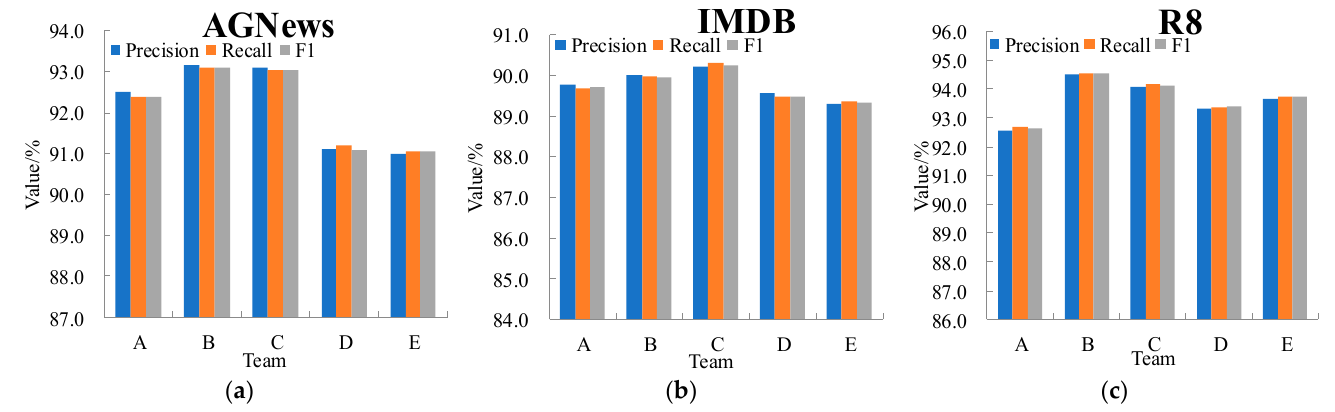
Figure 7. Experimental results for different size groups of convolution kernels. ( a ) represents the influence of different convolution kernel sizes on the classification effect of AGNews dataset; ( b ) represents the influence of different convolution kernel sizes on the classification effect of IMDB data sets; ( c ) represents the influence of different convolution kernel sizes on the classification effect of R8 dataset. Table 5. Groups of different sizes of convolutional kernels.